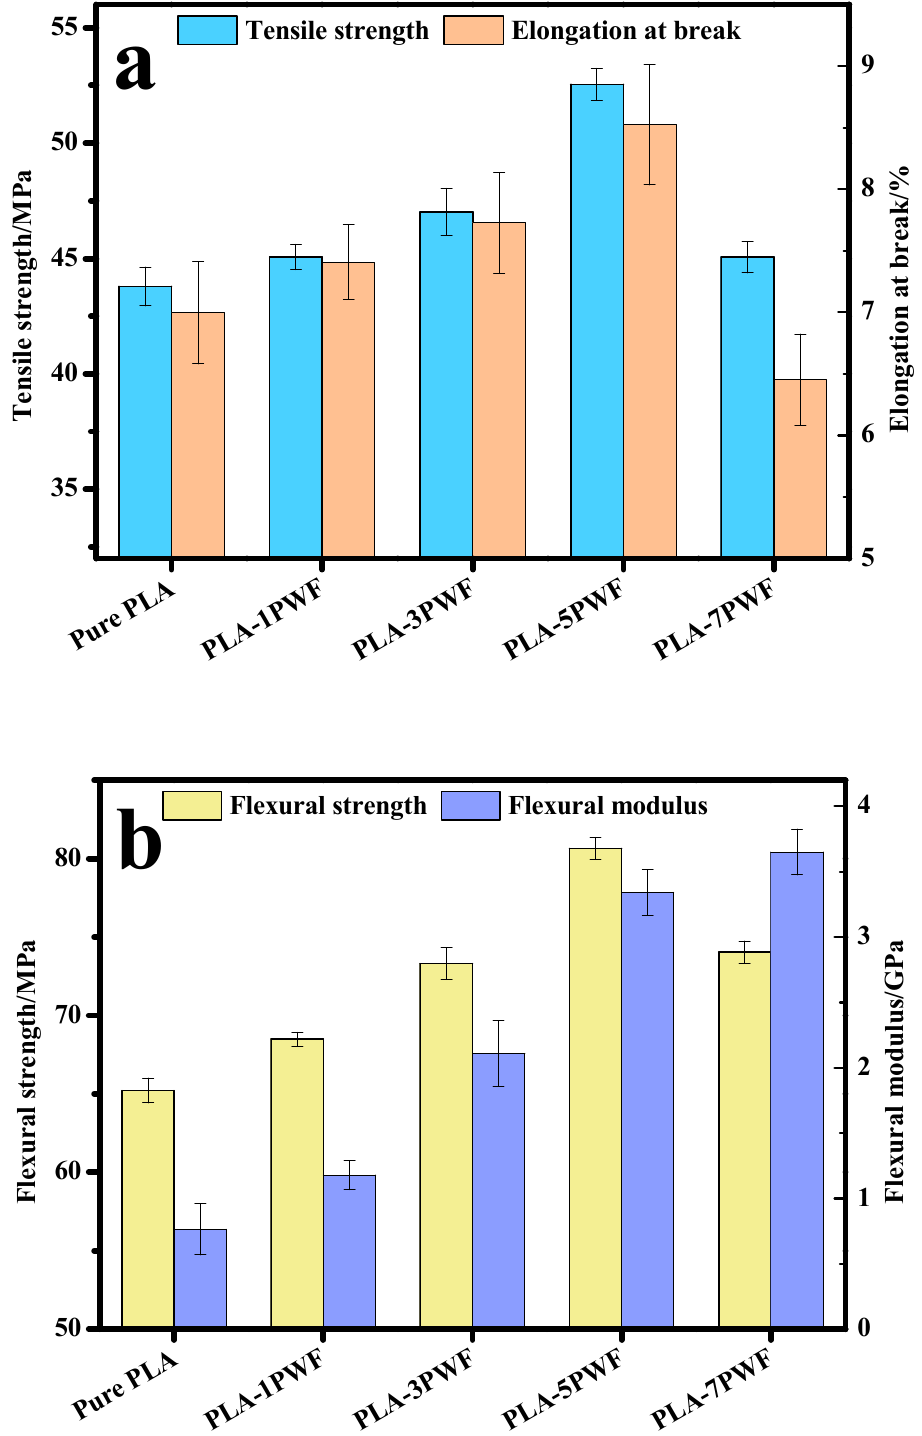
Figure 5. Tensile properties ( a ) and flexural properties ( b ) of PWF/PLA composites samples. Table 2. Mechanical properties of PWF/PLA and mCu ‐ Zn/PWF/PLA composites.